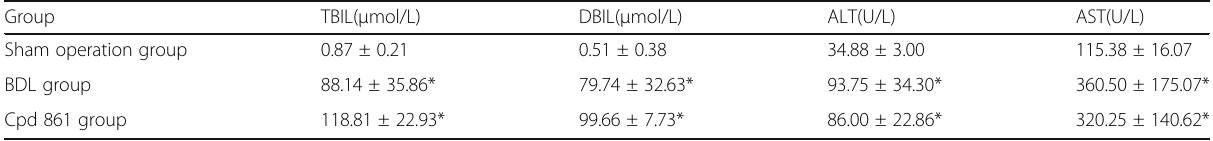
Table 3 Effect of Cpd 861 on serum biochemical indicators Group